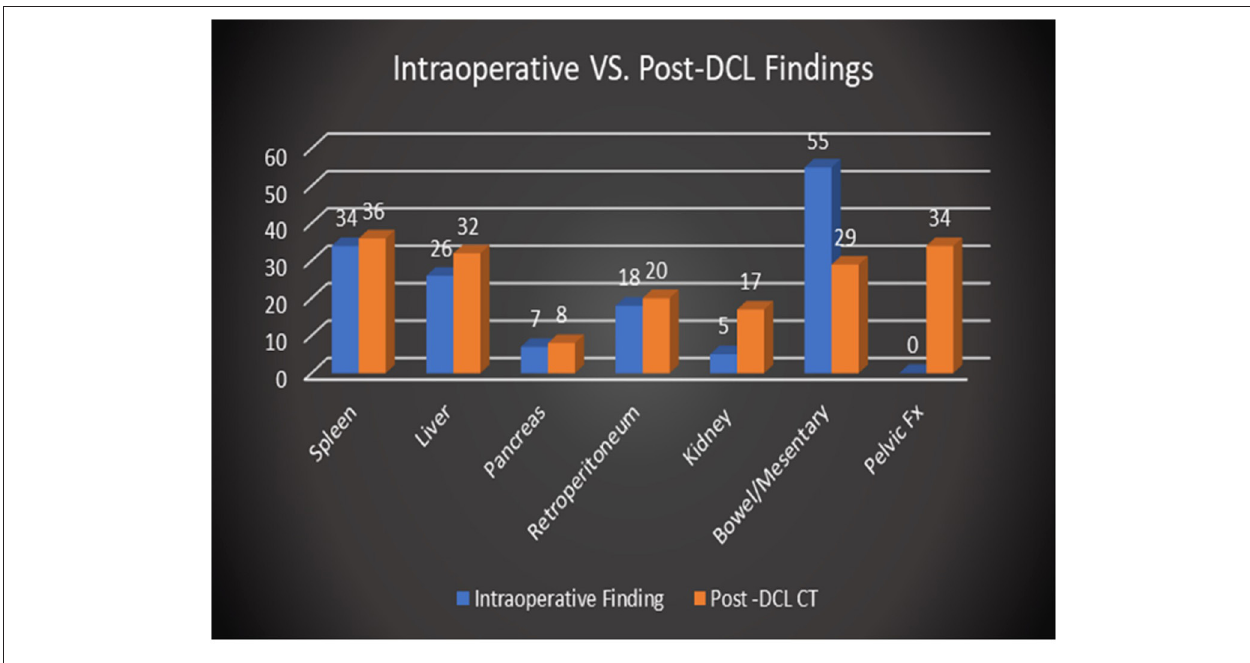
FIGURE 2 | Comparison of overall distribution of injuries reported intraoperatively vs. on post-DCL CT.